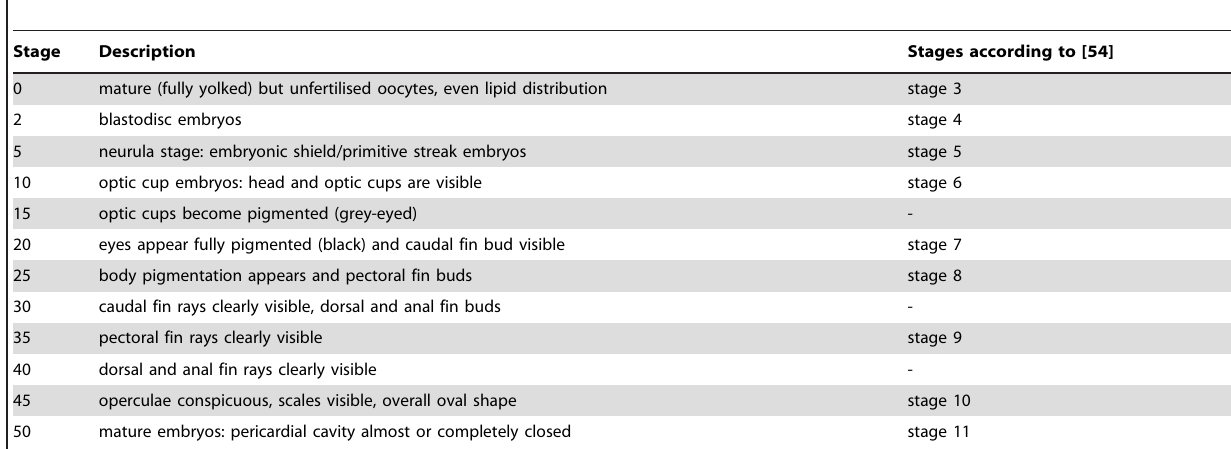
Table 1. Embryo development in poeciliid fishes. According to Reznick [103] and compared to the generalized description provided by Haynes [54]